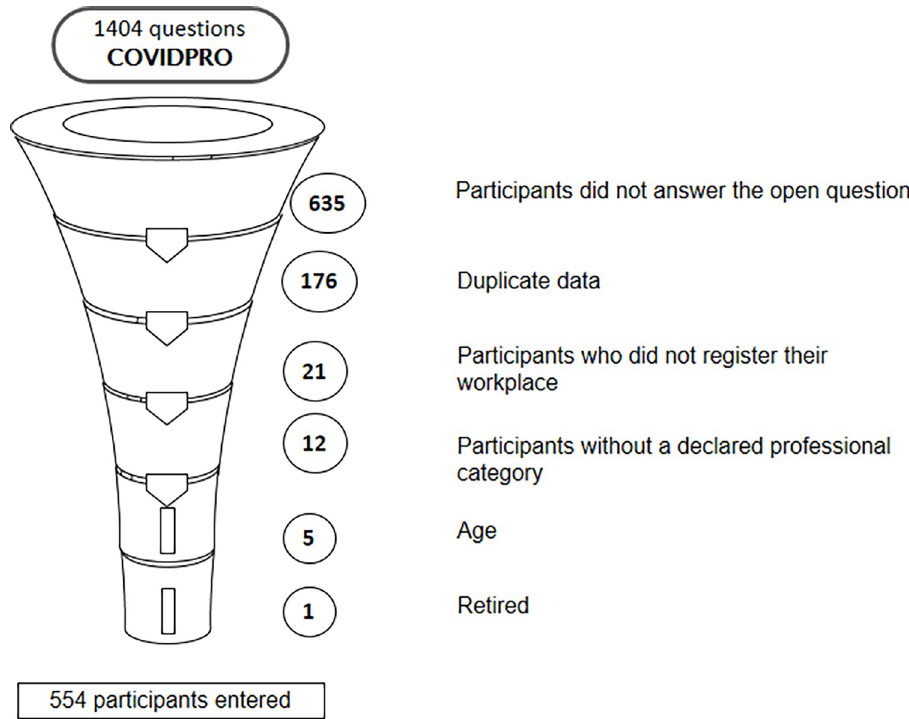
Fig 1. Participant recruitment diagram. Source: COVIDPRO Project (2020). Rio de Janeiro–Brazil, 2020. (N = 554).